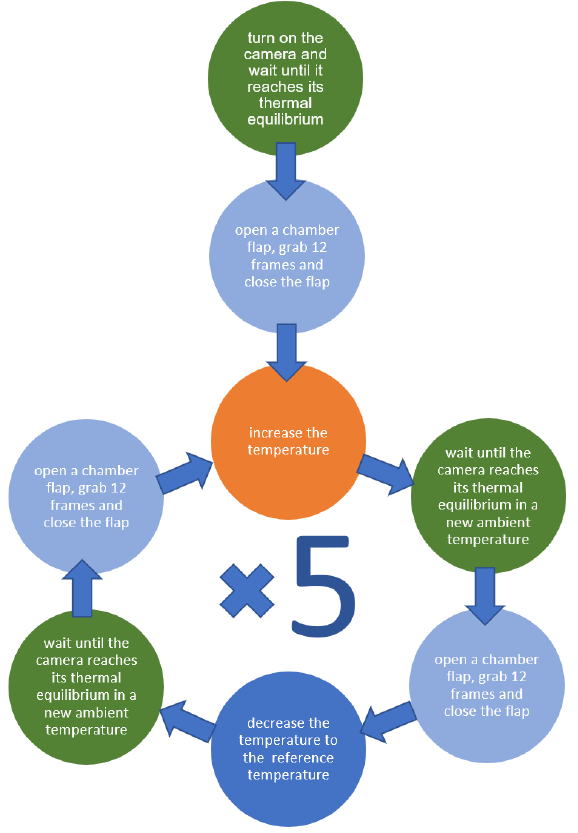
Figure 8. Workflow for the experiment with the modified camera unit. The temperature was increasing gradually, starting from the reference temperature. The aim was to observe the presence of any hysteresis associated with the camera’s thermal